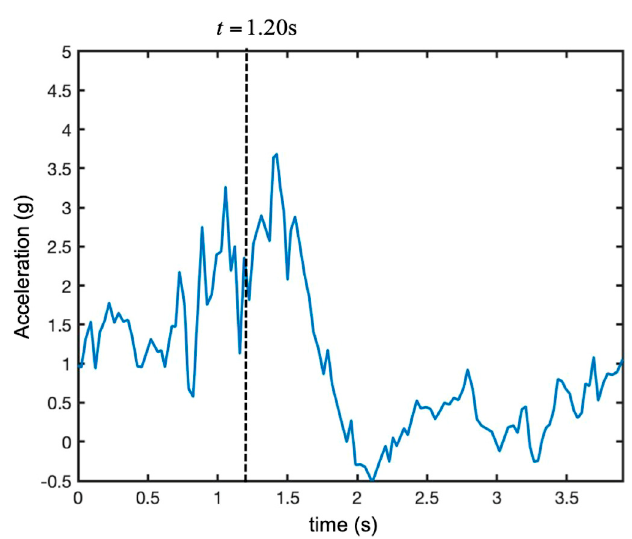
Figure 22. Recorded vertical acceleration of the UAV during maneuver 2 (i.e., rapid take-off).